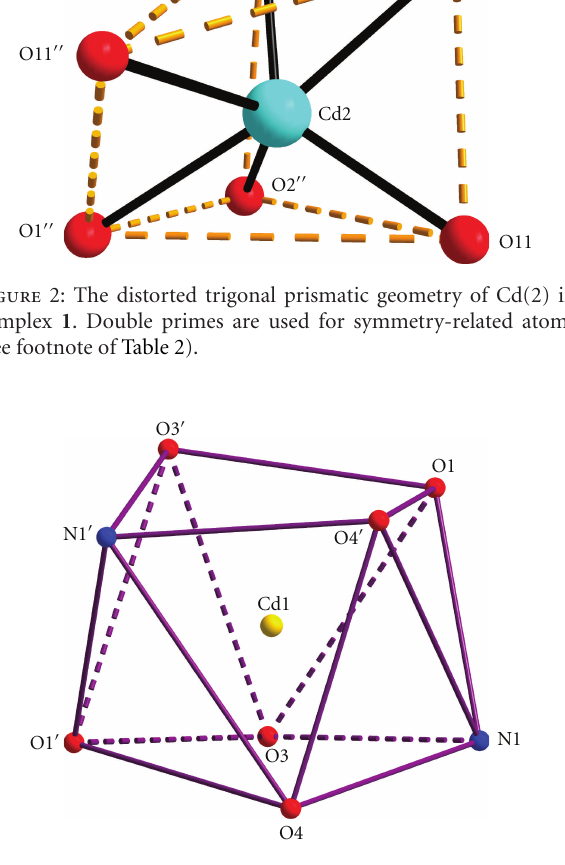
Figure 3: The distorted square antiprismatic stereochemistry about Cd(1) in complex 1 . The coordination bonds have not been drawn for clarity. Primes are used for symmetry-related atoms (see footnote of Table